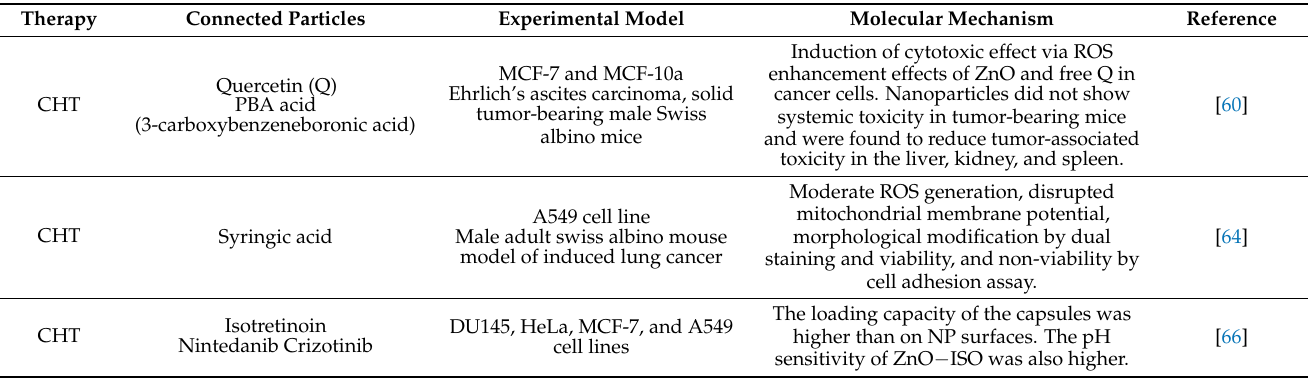
Table 6. Selected connections of biologically active molecules with zinc